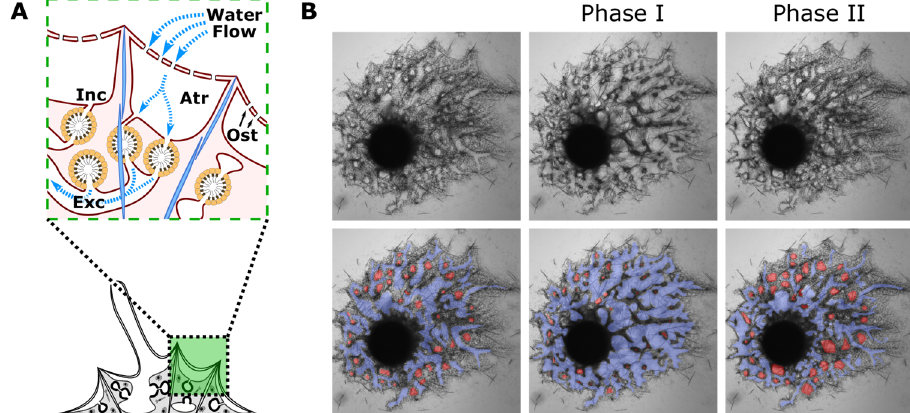
Fig. 1 Sponge body plan and contractions. A The tent-like outer layer is supported by spicules (light blue) and is composed of two epithelia, which house a thin extracellular matrix (pink) containing migratory cells. The incurrent system (Inc) comprises the atrium and incurrent canals. Water is drawn into the atrium through incurrent pores (ostia; Ost) and into choanocyte chambers (orange), then into excurrent system (Exc) and through the osculum where it exits the sponge. B Still images from a mechanically induced contraction show that a ~40 min contraction cycle involves at least two phases. During phase I ( t = 15 min), incurrent canals (red) narrow as excurrent canals (blue) widen. During phase II ( t = 36 min), incurrent canals widen as excurrent canals